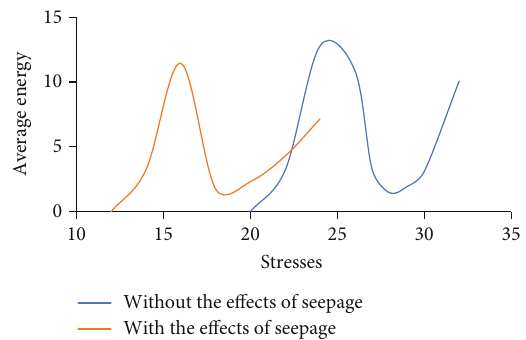
Figure 11: The average energy-stress